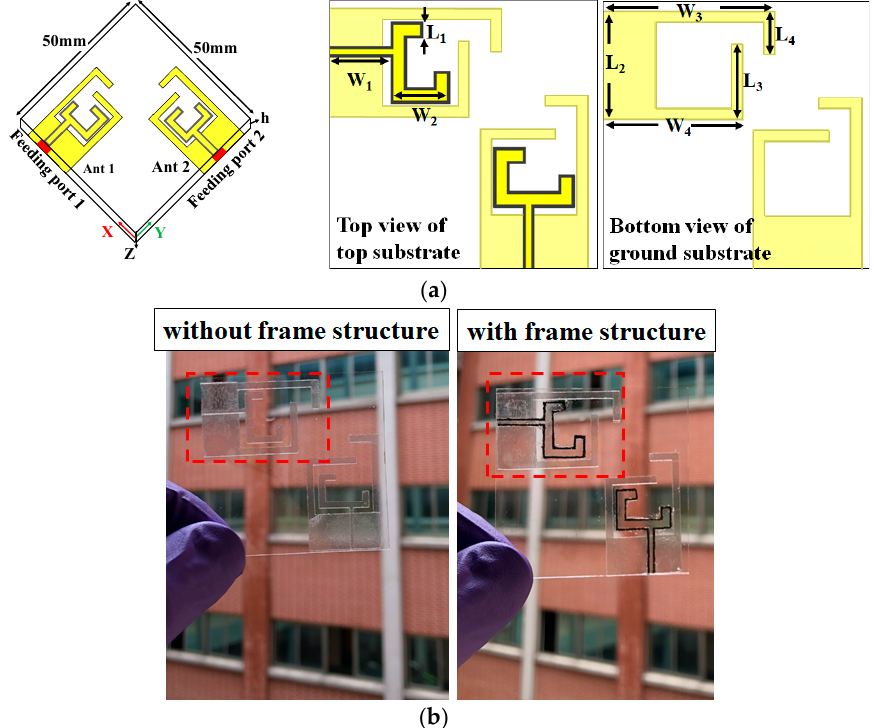
Figure 3. ( a ) Configuration of the proposed dual-band transparent antenna using the frame-structured metal mesh conductive film and ( b ) photograph of the fabricated antenna. (L 1 = 3, L 2 = 20, L 3 = 14, L 4 = 8, W 1 = 11.5, W 2 = 11.5, W 3 = 32, W 4 = 26, h = 0.5, W f = 0.5, h c = 0.003, all are in mm).